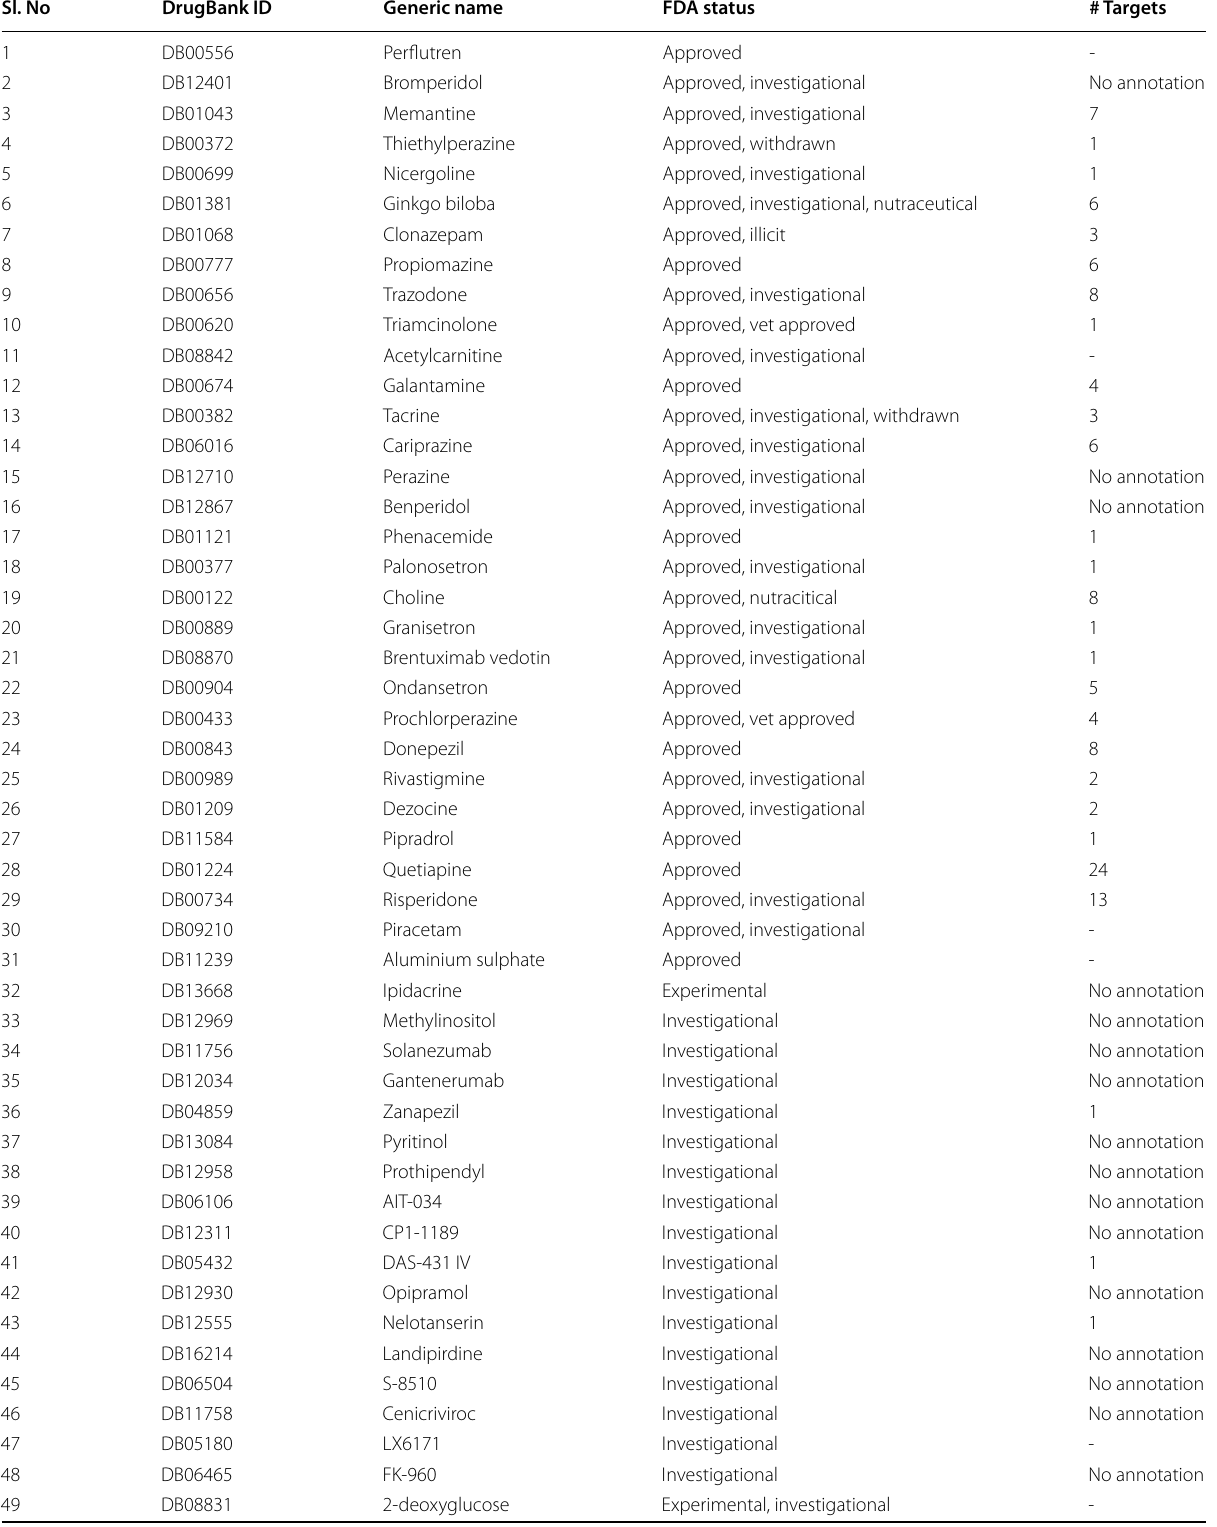
Table 1 Summary of frontotemporal dementia drugs, FDA status and number of targets based on DrugBank annotation Sl.